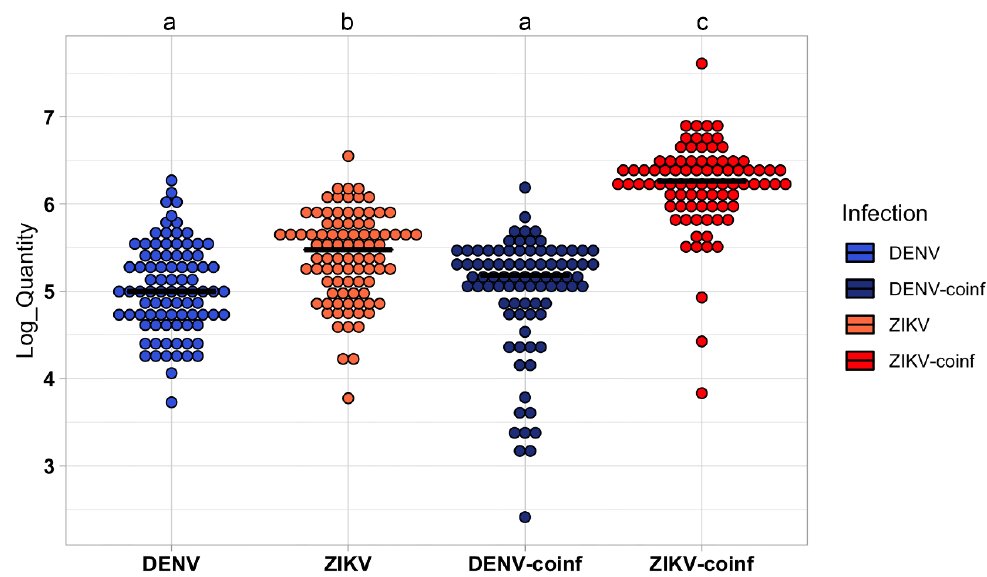
Figure 2. The number of viral copies in Aedes aegypti females at 14 dpi when mosquitoes were either single infected with ZIKV or DENV, or simultaneously co-infected with both ZIKV/DENV. Different letters indicate statistically significant differences (Wilcoxon rank sum test (U-test), p < 0.001). Each circle represents an individual mosquito; negative control samples (uninfected Ae. aegypti from laboratory colony) are not shown because they did not produce any amplification signal.